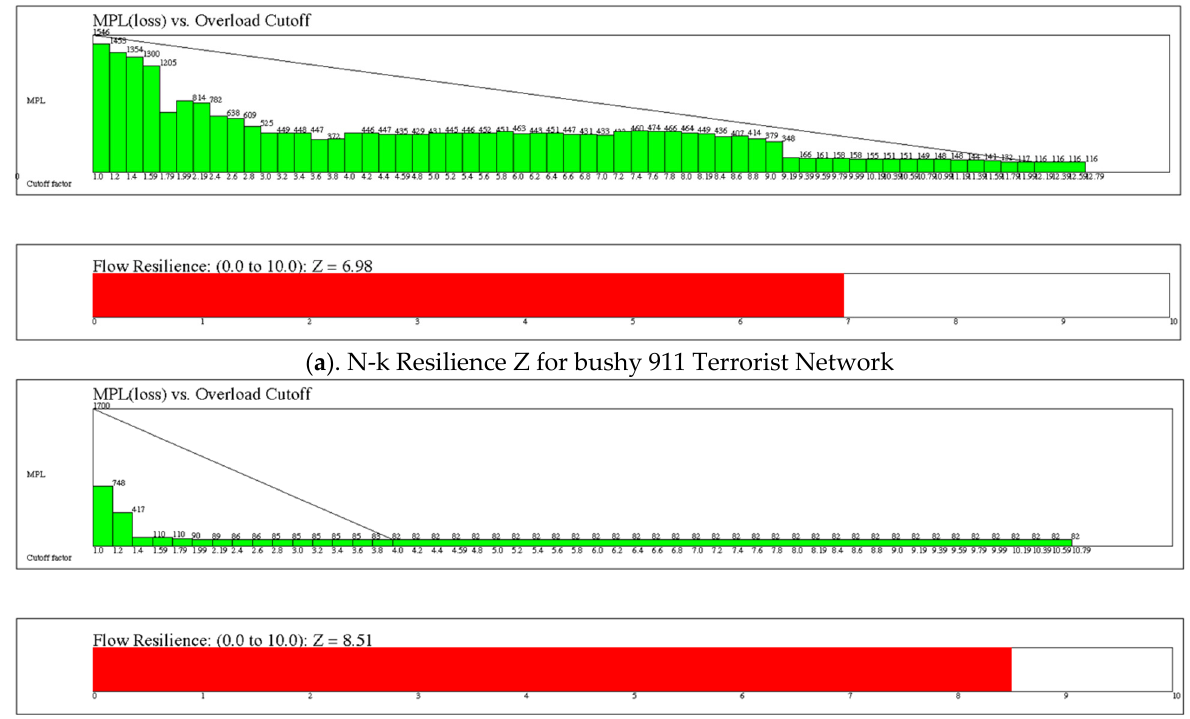
Figure 10. ( a ). Flow resilience Z test for 911 Terrorist network with bushy of 1/0.58 = 1.72 and resilience of 6.98. ( b ). Flow resilience test for the LA Metro network with branchy of 11.65 and resilience of 8.51.